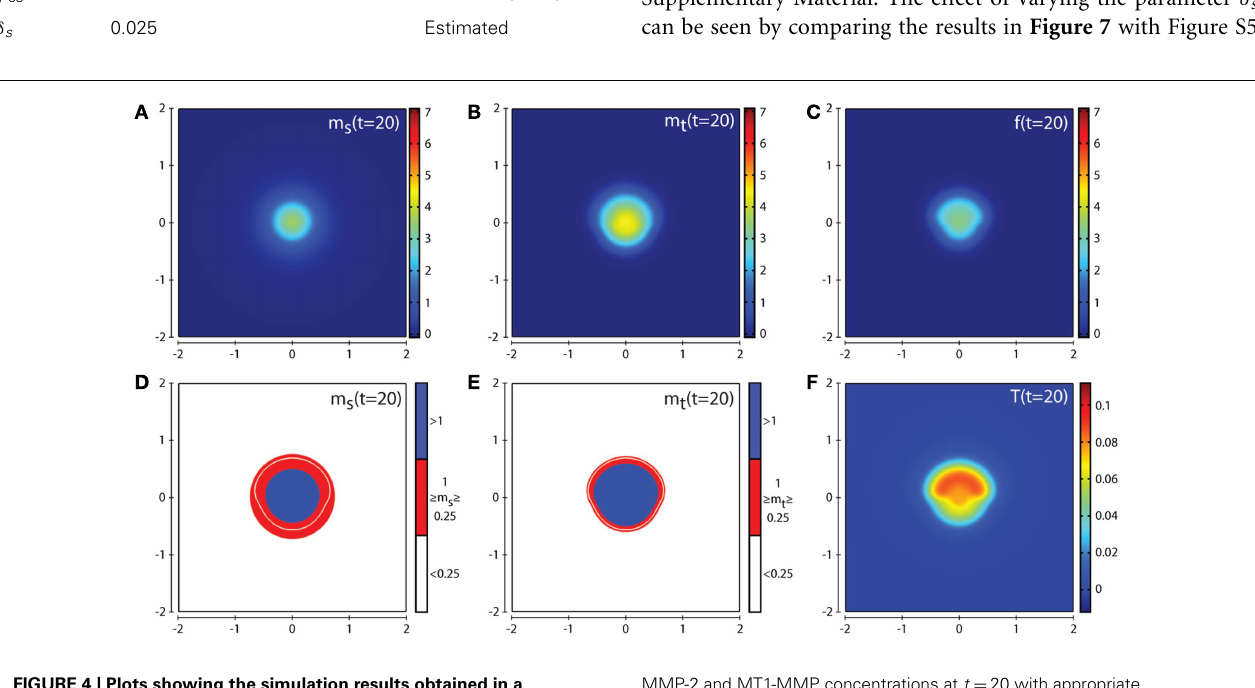
FIGURE 4 | Plots showing the simulation results obtained in a two-dimensional domain where asymmetric invasion of the ECM is achieved by the cancer cells. The concentrations of MMP-2, MT1-MMP, the intermediary complex f , andTIMP2 at t = 20 (corresponding to ∼ 2.3days) are shown in plots (A–C,F) respectively. Plots (D,E) show the